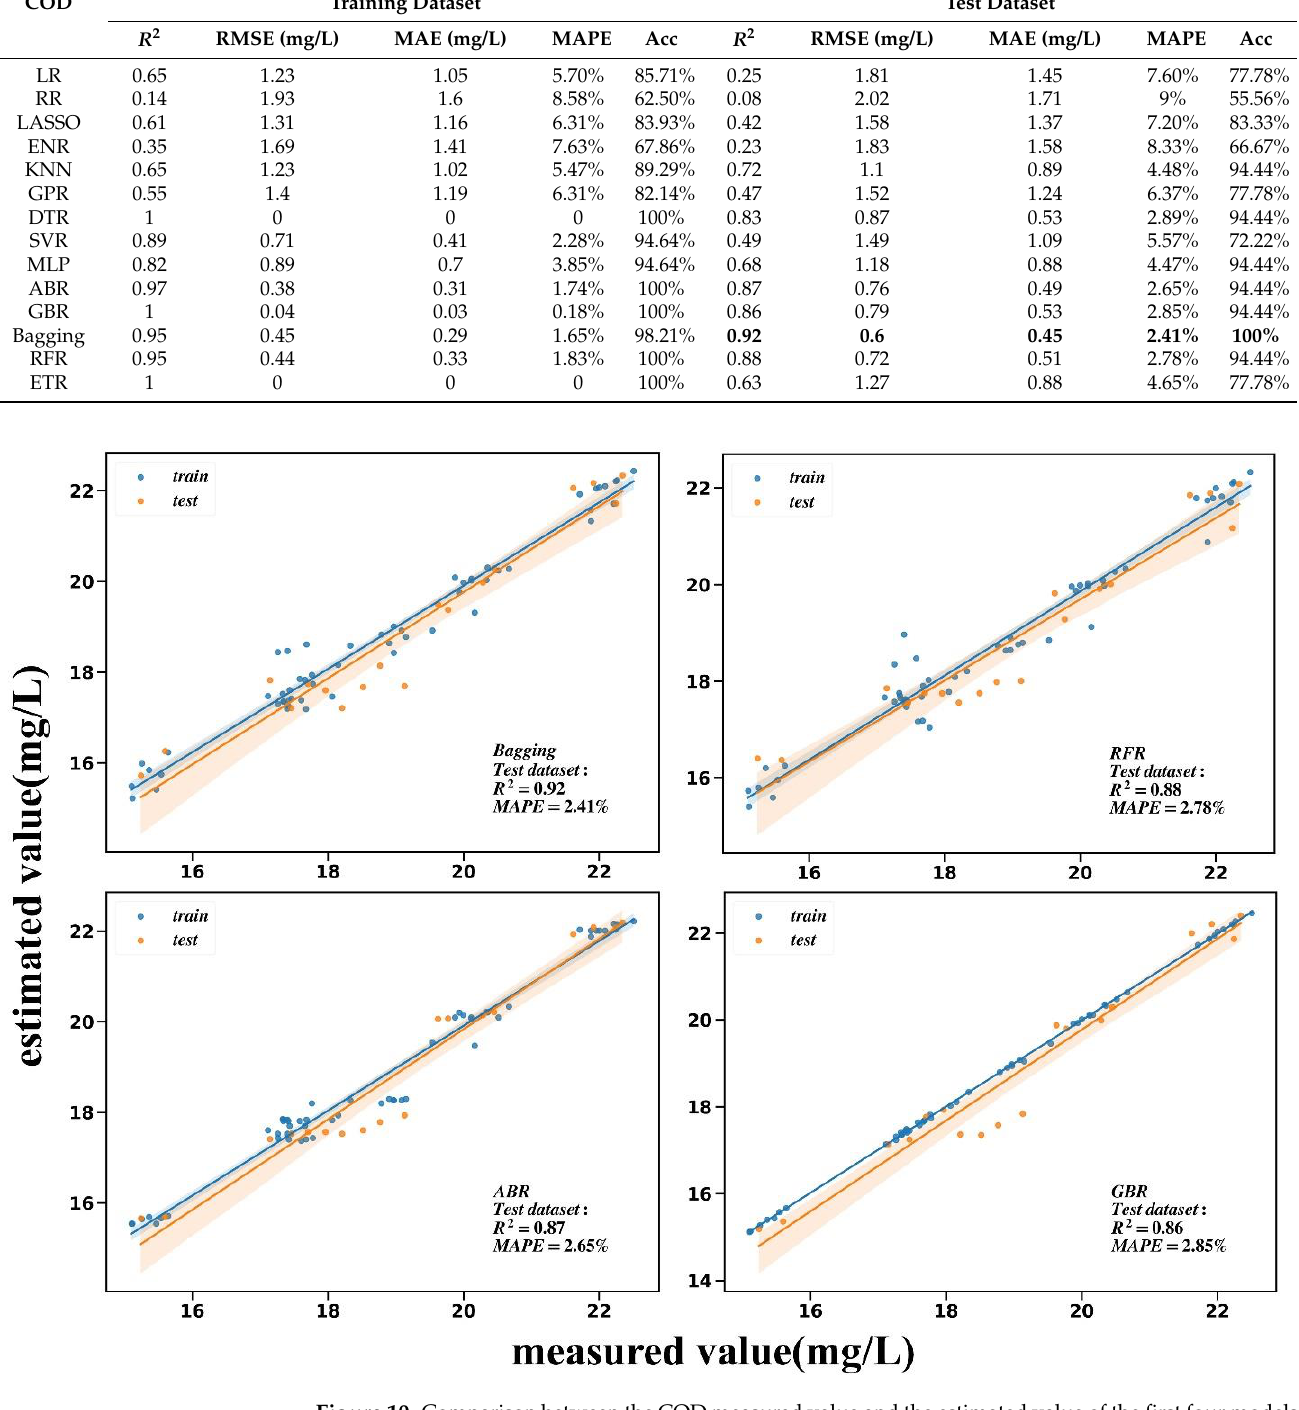
Figure 10. Comparison between the COD measured value and the estimated value of the first four models with the highest R 2 of the test dataset. Transparent color blocks represent 95% confidence intervals.